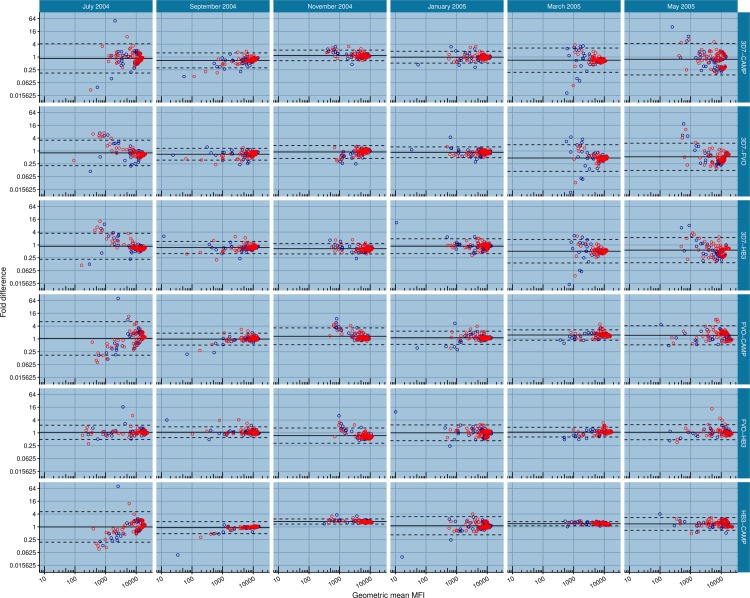
Pair-wise comparison of AMA1 allele-specific antibody levels.Points in a panel represent a plot of the fold difference between paired antibody levels (for example, the 3D7-CAMP panel plots the log-transformed anti-3D7 antibody levels minus anti-CAMP antibody levels) in plasma samples against the geometric mean (antilog) of the same paired allele-specific antibody levels. The bold horizontal line (line of equality) in each panel represents the average of all the differences between antibody levels against the specified antigen pair. The dotted horizontal lines represent the 95% limits of agreement for the distribution. Red open circles represent data from children with symptomatic malaria (Symp) and blue open circles are data from children with asymptomatic infections (Asymp).